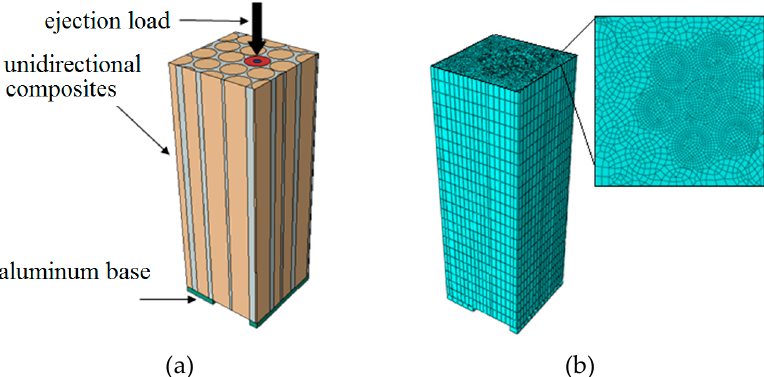
Figure 16. The simulation model of the fiber ejection test on the carbon/carbon (C/C) composite: ( a ) geometric model; ( b ) finite element model.